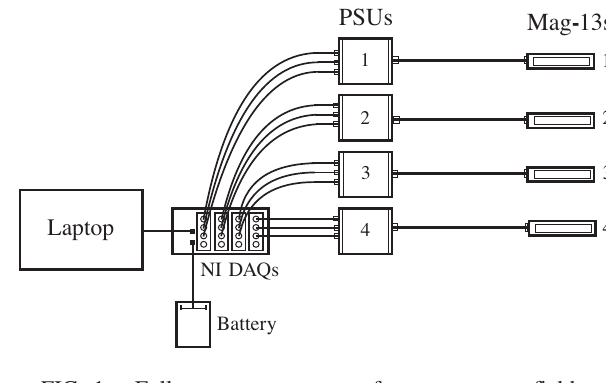
FIG. 1. Full measurement setup for survey